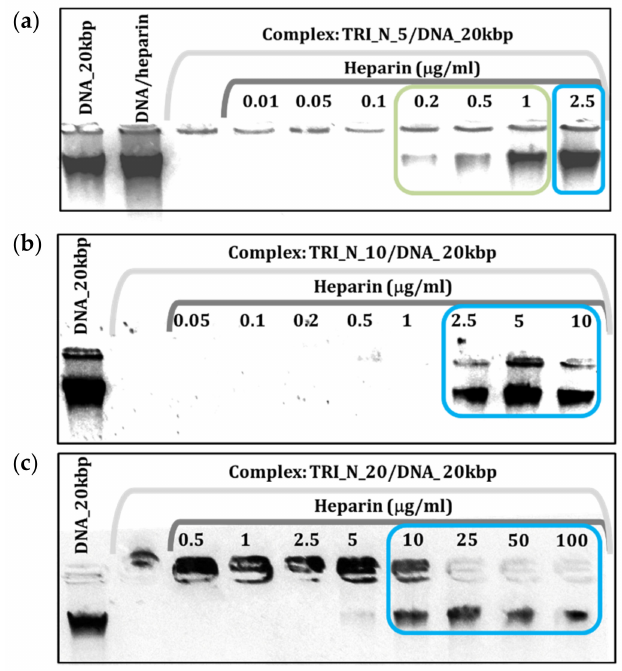
Figure 3. Agarose gel electrophoresis results obtained for lipoplexes based on ( a ) TRI_N/DNA_20kbp for p/n = 5, ( b ) for p/n = 10, and ( c ) for p/n = 20 with increasing heparin concentration.